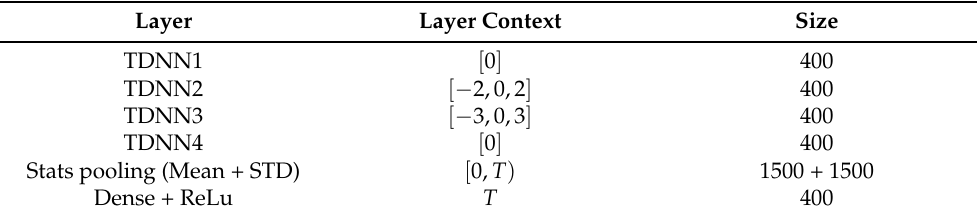
Table 1. Baseline architecture summary [21].